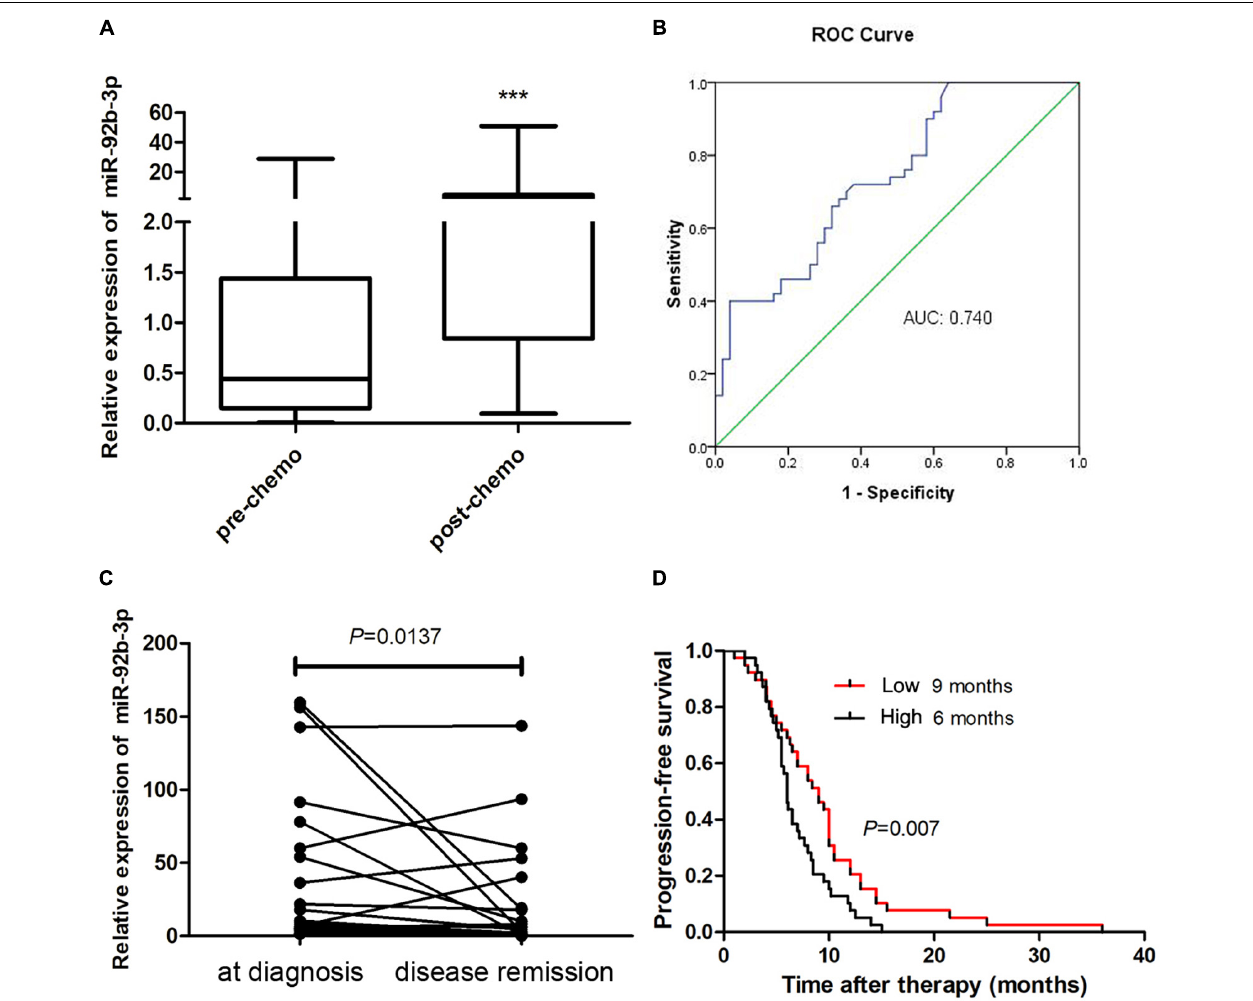
FIGURE 7 | MiR-92b-3p is a biomarker for monitoring the chemoresistance and prognosis of SCLC patients. (A) The expression of plasma miR-92b-3p in pre- and post-chemoresistant SCLC patients. (B) ROC curve analysis of plasma miR-92b-3p in pre- and post-chemoresistant SCLC patients. *** P < 0.001. (C) The level of circulating miR-92b-3p was particularly high in the plasma samples of SCLC patients who achieved disease remission. (D) Kaplan–Meier analysis showed that miR-92b-3p is a risk factor for the prognosis of SCLC patients. SCLC, small cell lung cancer and ROC, receiver operating characteristic.